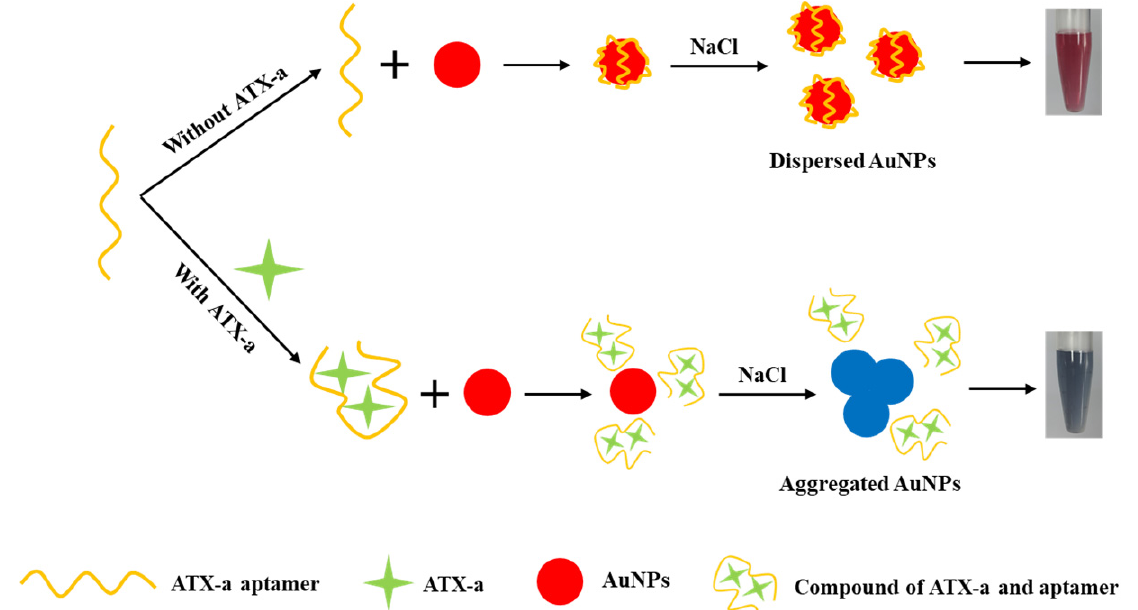
Figure 1. Schematic illustration of the colorimetric aptasensor for anatoxin-a (ATX-a) detection based on gold nanoparticle aggregation under high NaCl concentration.